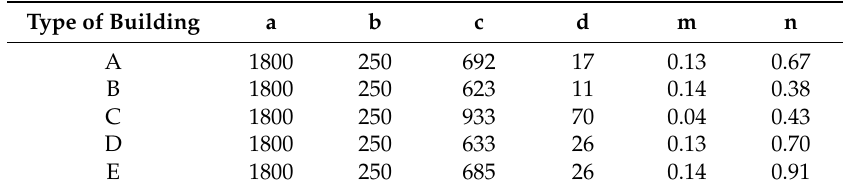
Table 1. Values of the coefficients “a, b, c, d, m, n” for the different structures characterizing the area examined [23].